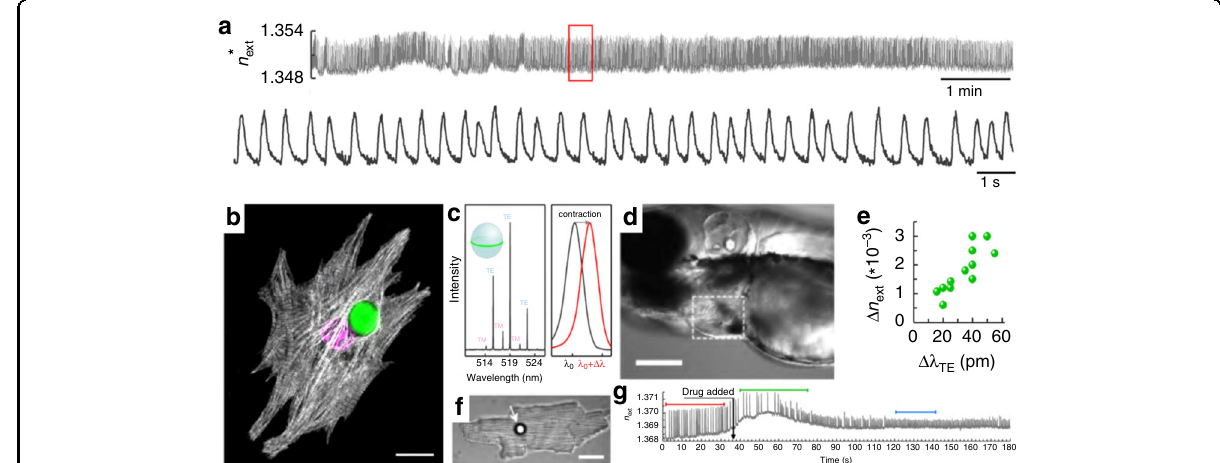
Fig. 6 Real-time tracking of individual cell contractility through changes in the refractive index with both internalised WGM microbeads and extracellular microbeads in contact with the cell membrane for nonphagocytic adult cardiomyocytes. a Continuous single-cell monitoring with an intracellular microbead over 10 min (top) at 2 nJ/pulse, and magni fi cation of the 20 s window indicated by the red rectangle (bottom). b 3D arrangement of myo fi brils around microbeads in neonatal cardiomyocytes (CMs). Cell nucleus (magenta) and microlaser (green). c WGM spectrum of a microlaser showing multimode lasing (left). Illustration of the redshift in the lasing wavelength upon CM contraction (right). d Microlaser attached to the atrium of a zebra fi sh heart (3 days post-fertilisation); scale bar 200 µm. e Average refractive index change ( Δη ext ) between the resting phase (diastole) and peak contraction (systole) for 12 individual cells. f Extracellular microlaser (white arrow) on top of an adult CM. Scale bar 30µm. g η ext trace of a spontaneously beating neonatal CM during administration of 500 nM nifedipine (black arrow). Reproduced from ref. 5